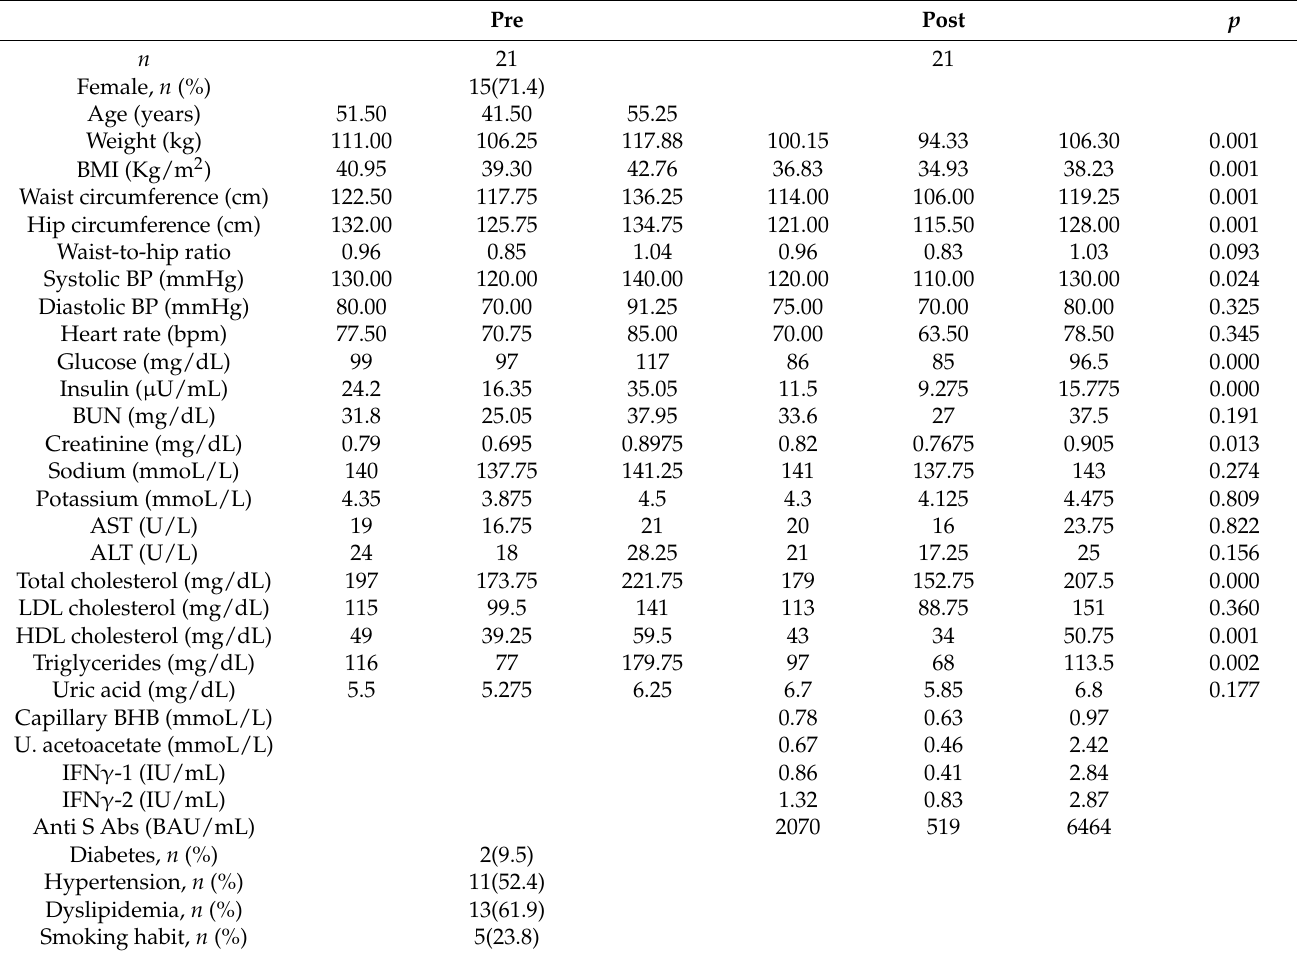
Table 1. Study population demographic, anthropometric and biochemical